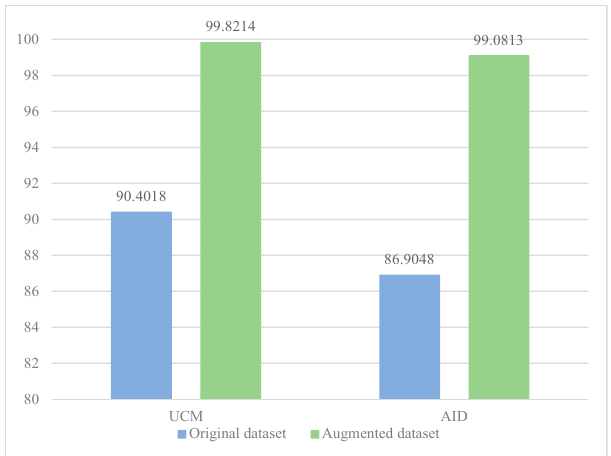
Figure 7. Overall accuracy of RDN + CBAM on the UCM and AID of the original dataset and the augmented dataset.